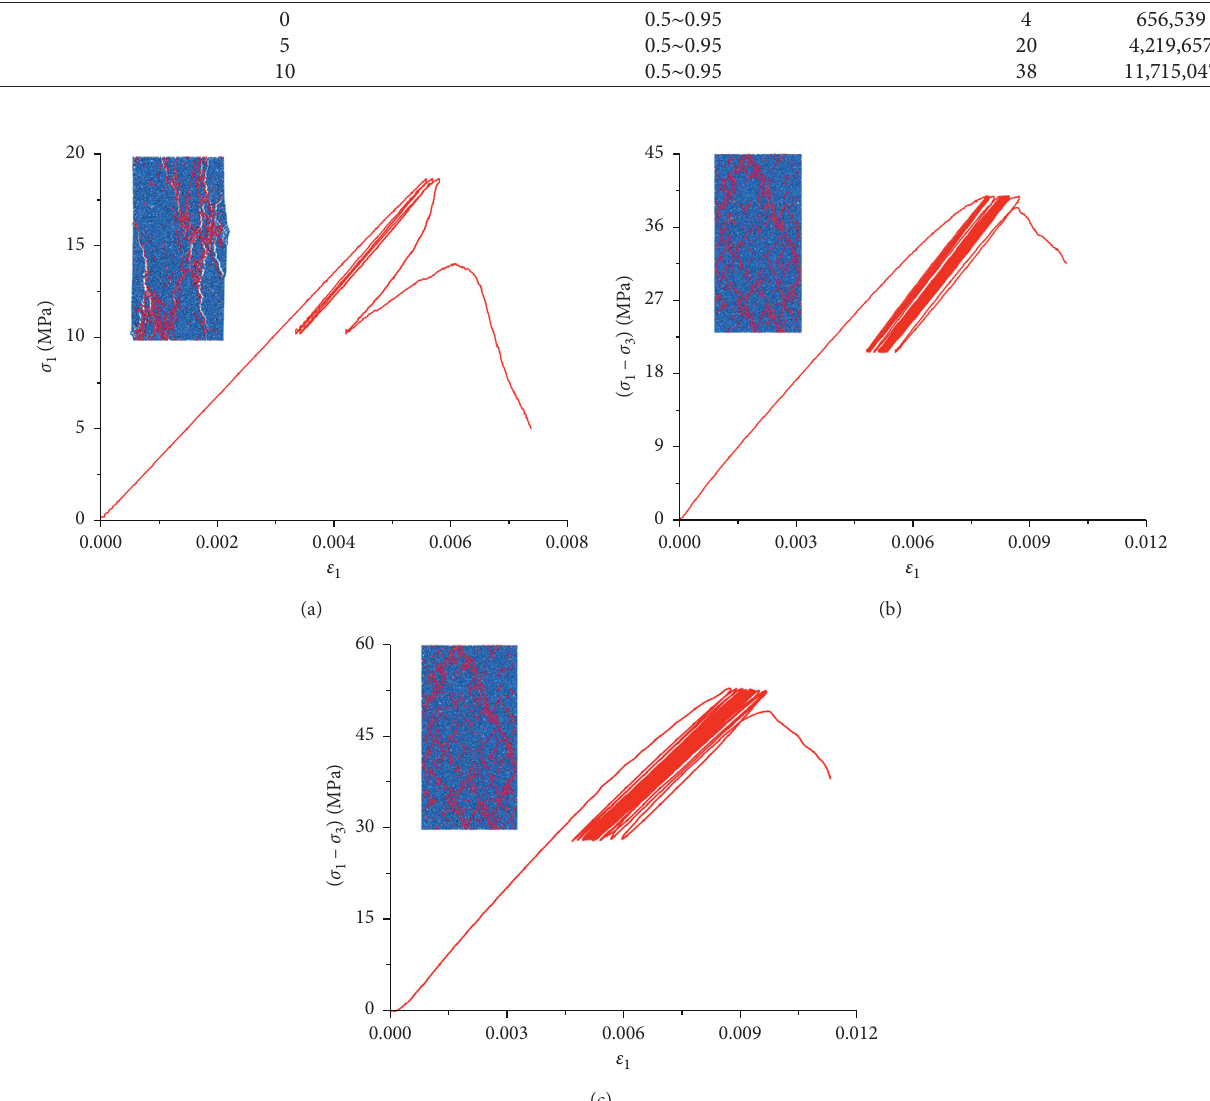
Table 3: Test conditions and results of coal specimen subjected to cyclic loading (the loading-unloading rate of 0.03m/s). Scheme number Confining pressure (MPa) Stress cycle interval (corresponding to peak strength) Cycle number